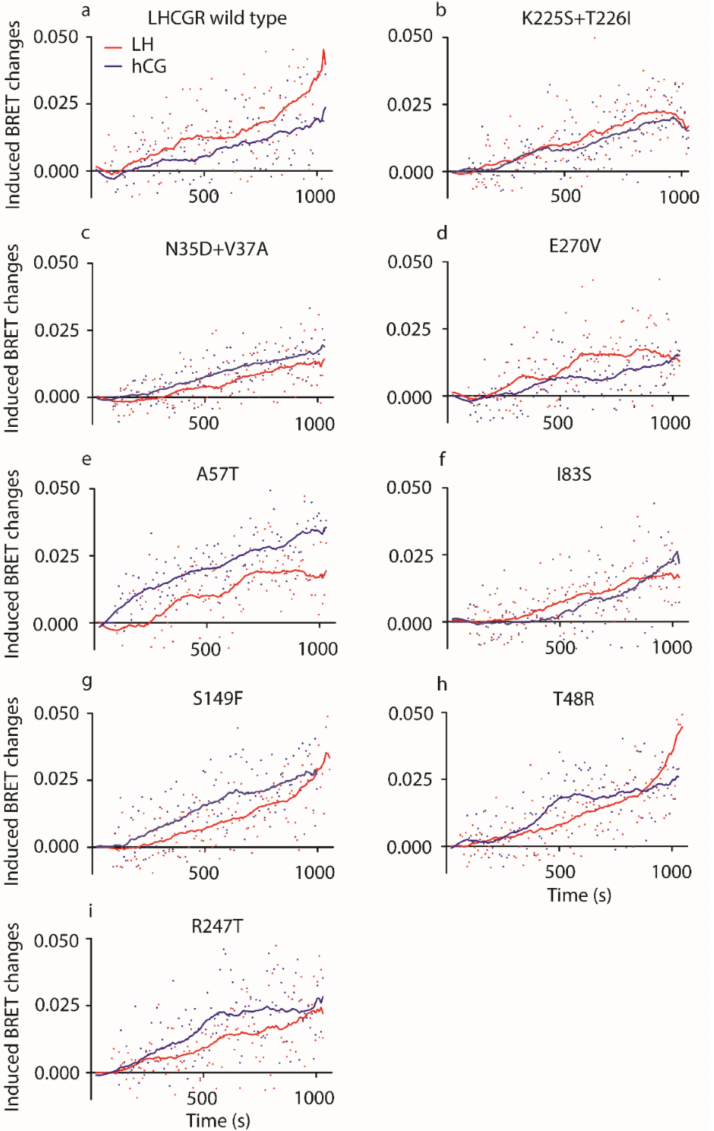
Figure 3. LH- and hCG-induced pERK1/2 activation. In HEK293 cells transiently overexpressing ( a ) the wild type receptor, ( b ) the K225S + T226I, ( c ) the N35D + V37A, ( d ) the E270V, ( e ) A57T, ( f ) I83S, ( g ) the S149F, ( h ) the T48R or ( i ) the R247T mutants, the kinetics of ERK1/2 phosphorylation was analyzed. Induced BRET changes obtained thanks to the interaction between the REV BRET- biosensor and pERK1/2 were measured over 1200 s upon administration of 100 pM LH or hCG. Data from LH/hCG-treated cells were represented by locally weighted scatterplot smoothing (LOWESS) of the induced BRET changes. All the LH- vs hCG-induced kinetics of ERK1/2 phosphorylations are different, except those mediated by the K225S + T226I and I83S mutants (Kruskal–Wallis test and Dunn’s Multiple Comparison post-test; p ≥ 0.05; each point is the mean value from eight independent experimental